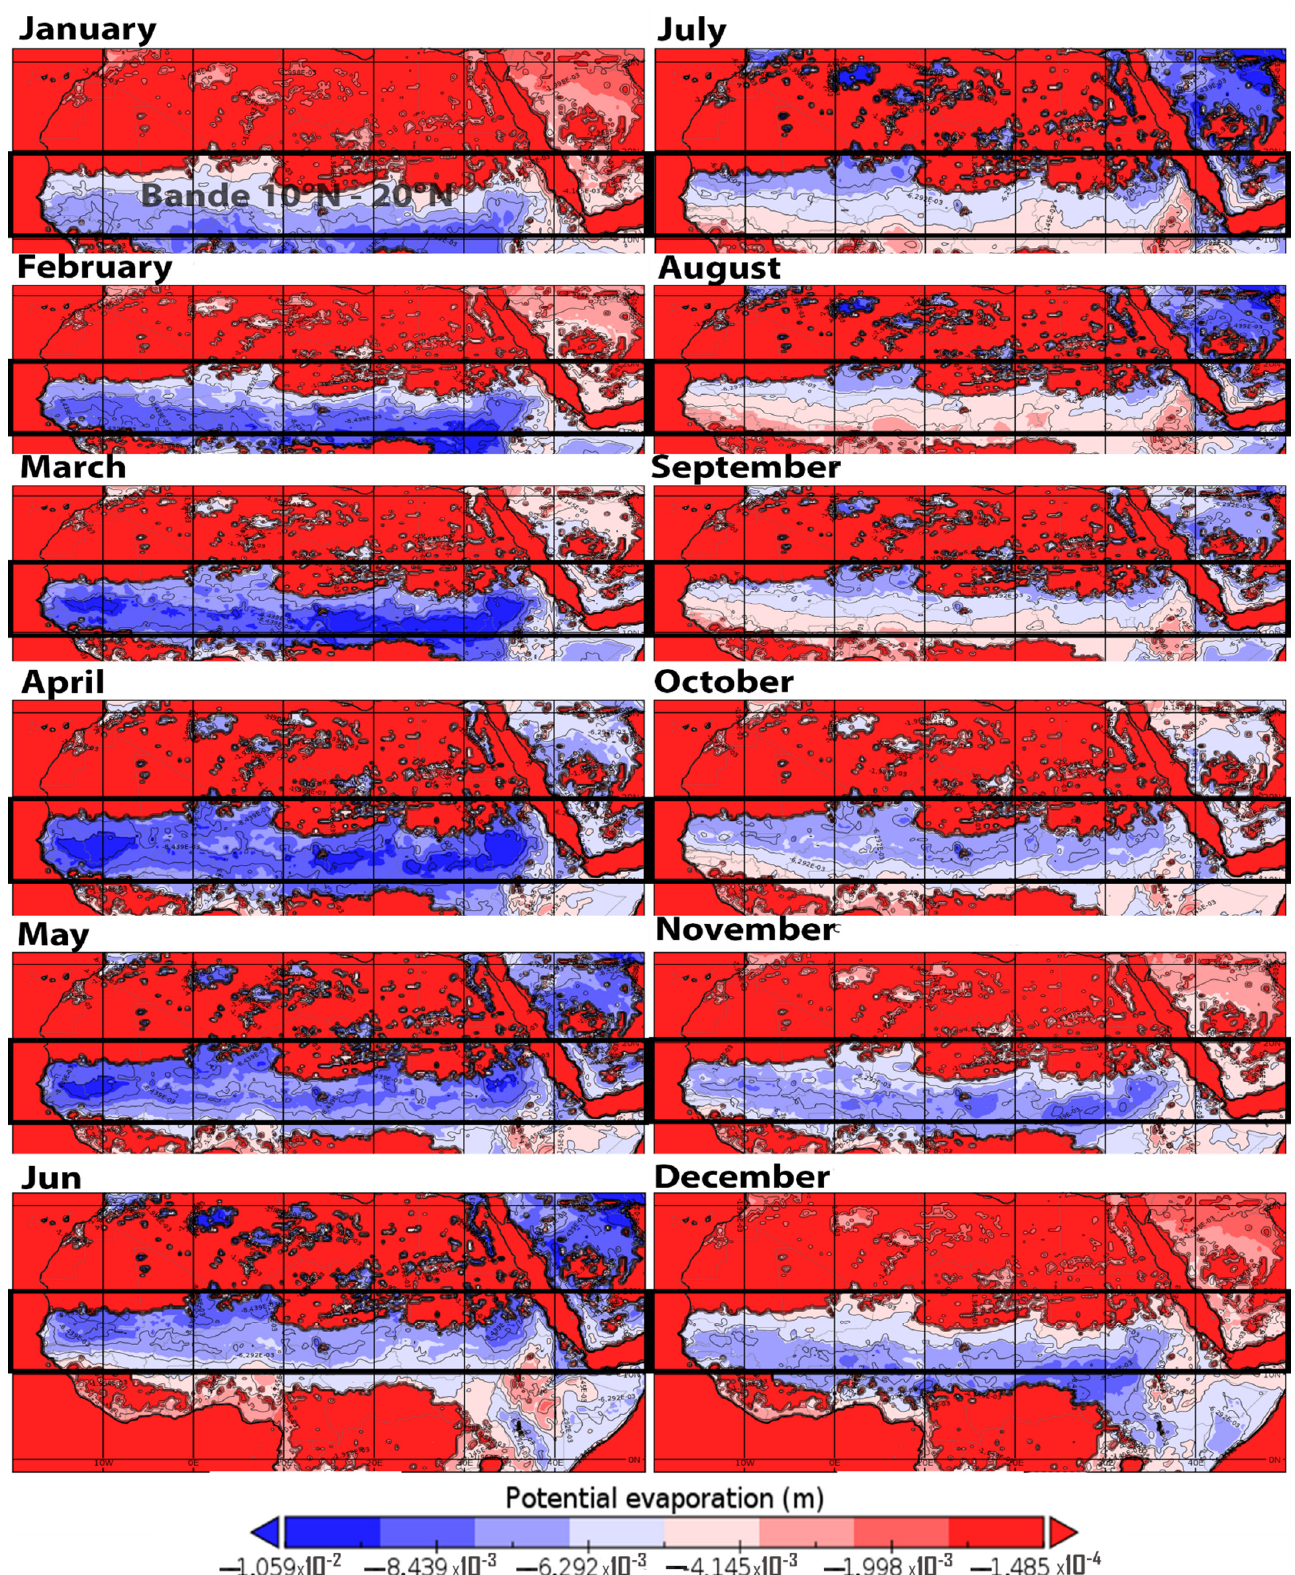
Figure 7. Climatology of monthly mean evapotranspiration (4D-Var ERA5) in m water equivalent 1979 to 2008, with a resolution of 0.5 × 0.5 degrees. Data from the ERA5 platform.